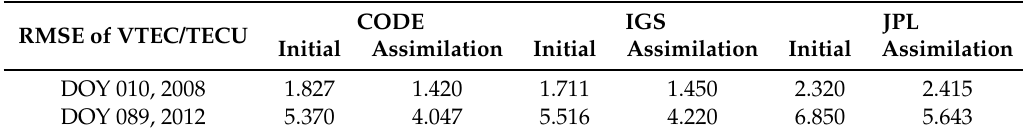
Table 3. Statistics of VTEC’s daily residual between ionospheric assimilation result with a G/S+Cor strategy and GIMs from different data centers. CODE IGS JPL RMSE of VTEC/TECU Initial Assimilation